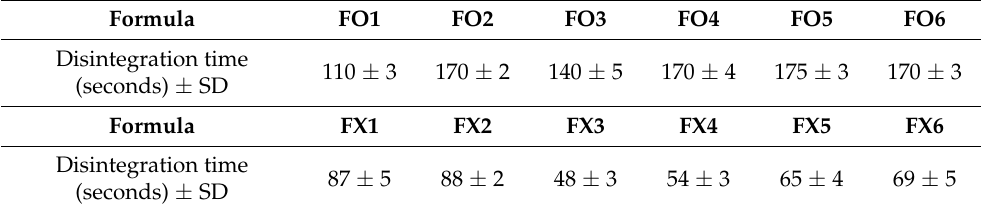
Table 5. Disintegration time of the orodispersible films.